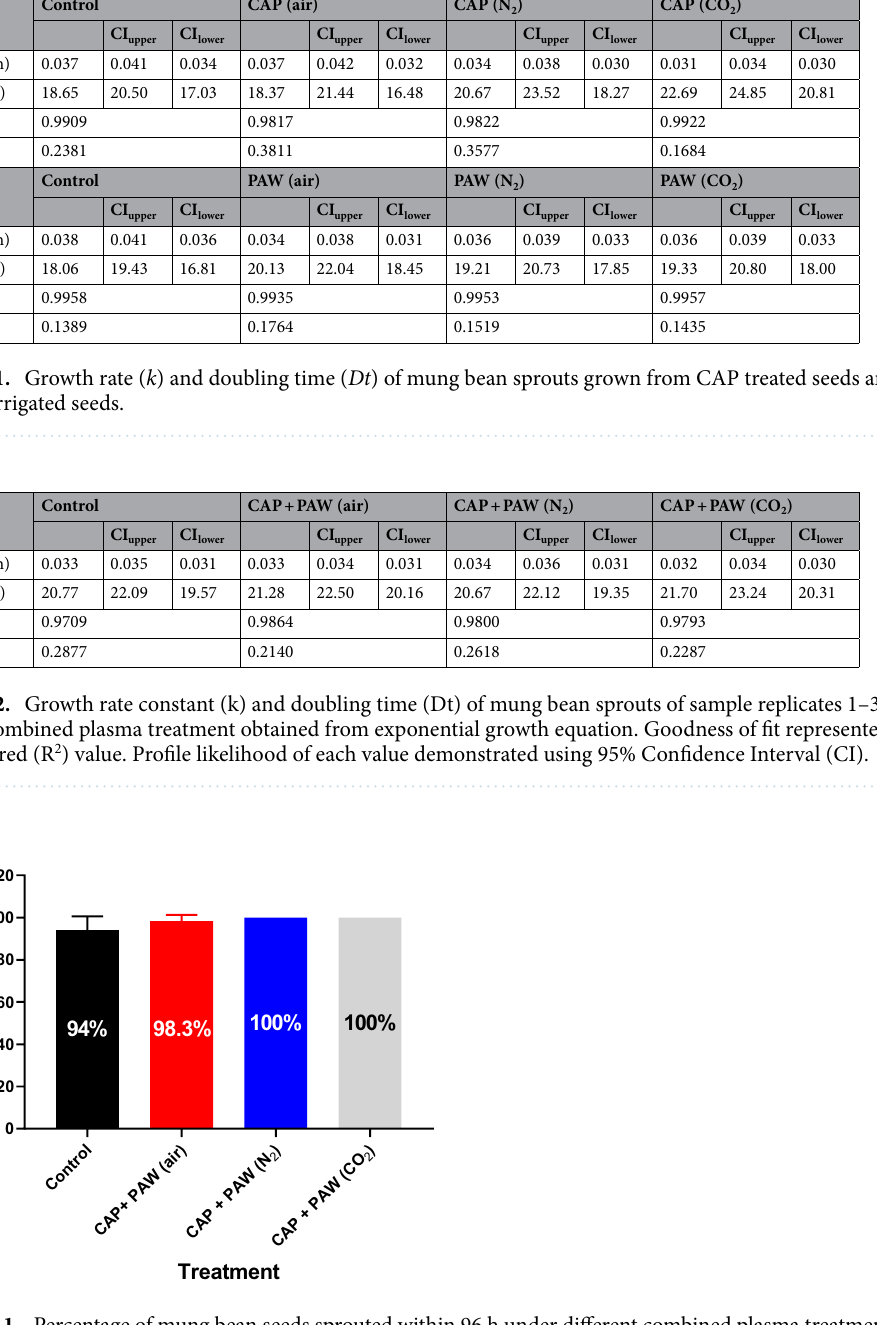
As observed in Table 2, the growth rate of mung bean sprouts appeared to be relatively similar with only a 0.001 1/h difference between the control and the combined plasma treatments in N 2 [CAP + PAW (N 2 )] and in CO 2 [CAP + PAW (CO 2 )]. In comparison to the control, the Dt varied by + 0.77 h, − 0.10 h and + 0.93 h for the combined plasma treatments in air [CAP + PAW (air)], N 2 and CO 2 respectively. However, statistical analysis determined no significant difference between the k and Dt values of the control to the treated groups as the p values (P) exceeded the 0.05 minimum level of significance in each case. Mung bean seed germination percentage, i.e., the percentage of seeds that sprouted by the end of the 96 h experiment under the different treatments are presented in Fig. 1. While slight increases in germination per- centage were demonstrated by the combined plasma treatments in air (+ 4.3%), in N 2 (+ 6%) and in CO 2 (+ 6%) compared to the control, these increases were not found to be significantly different (P > 0.05).